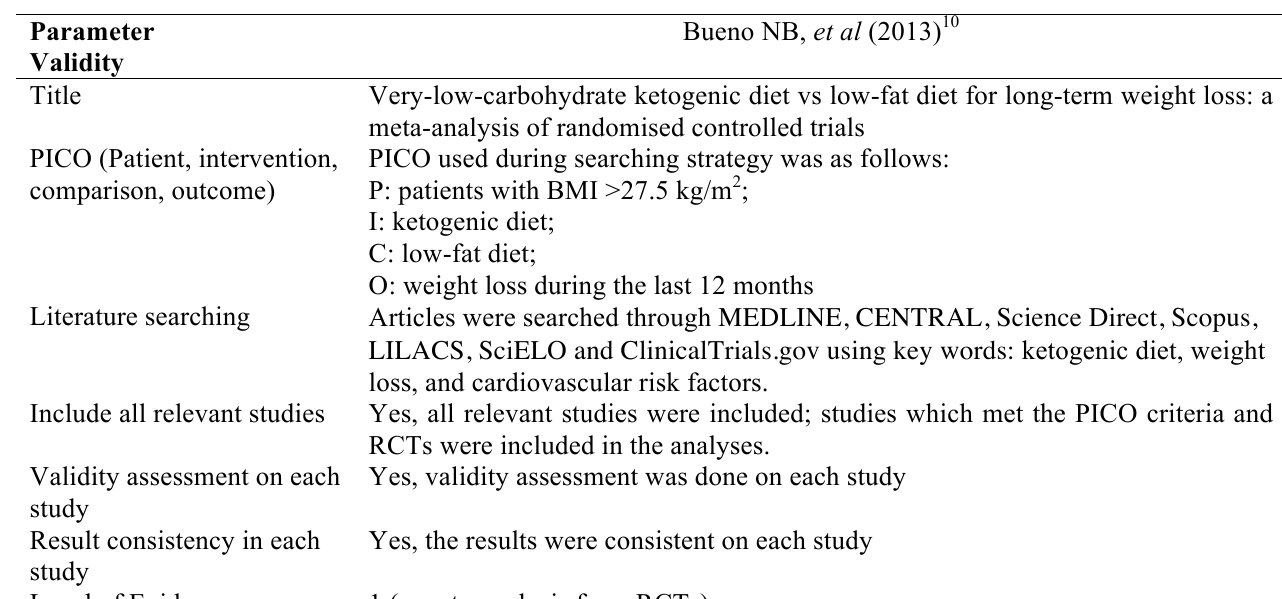
Table 4. Critical appraisal on the validity aspect of